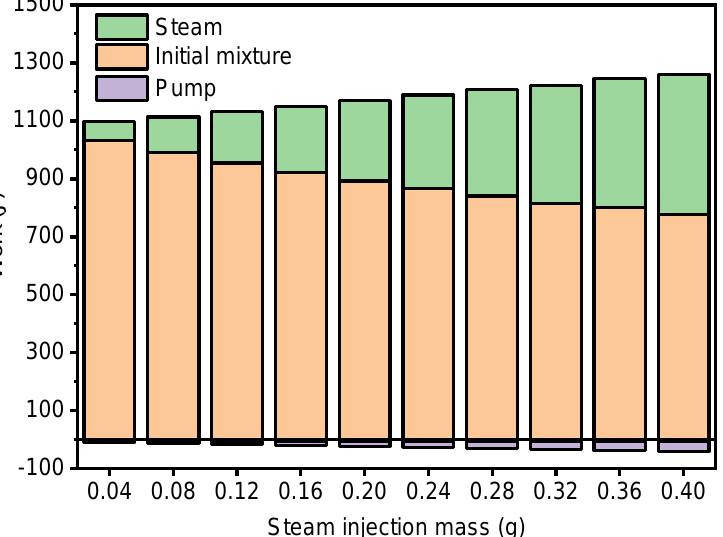
Figure 5. Work output according to steam injection mass (P steam = 20 MPa; T steam = 450 K; P intake = 0.1 MPa; CR = 10).